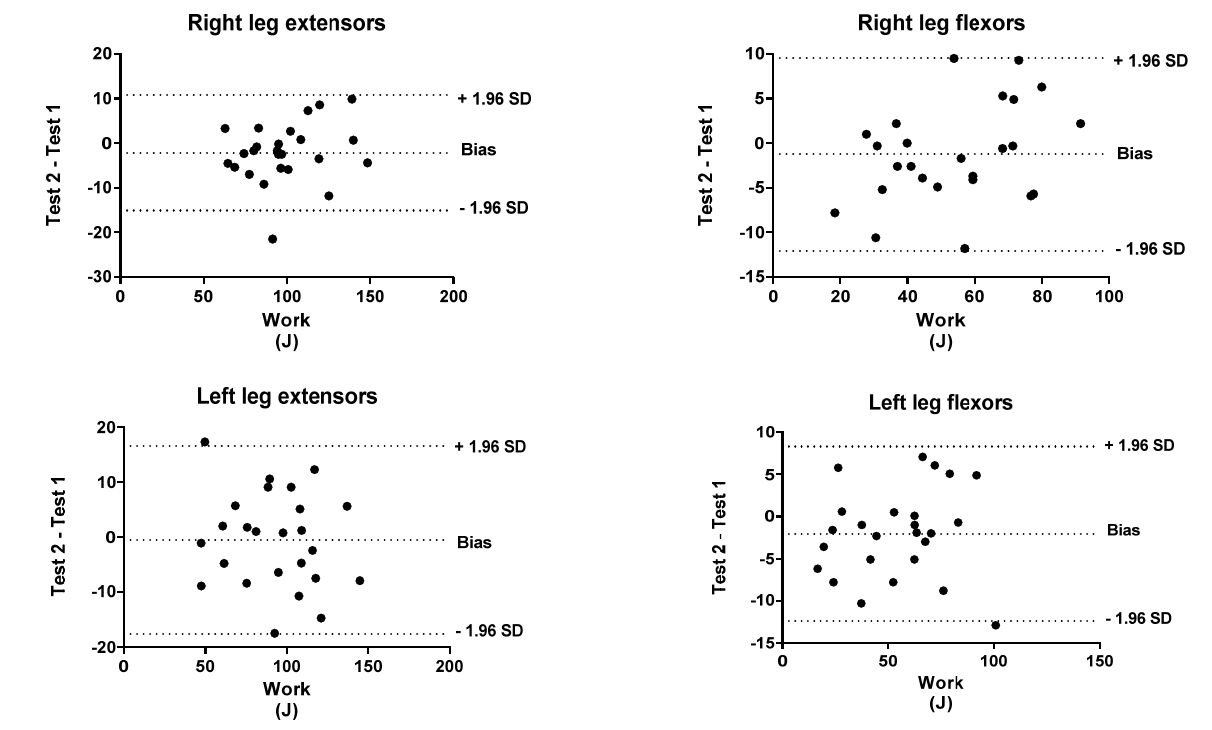
Figure 6. Men Bland–Altman work analysis for Right and Left Legs in flexion and Extension.